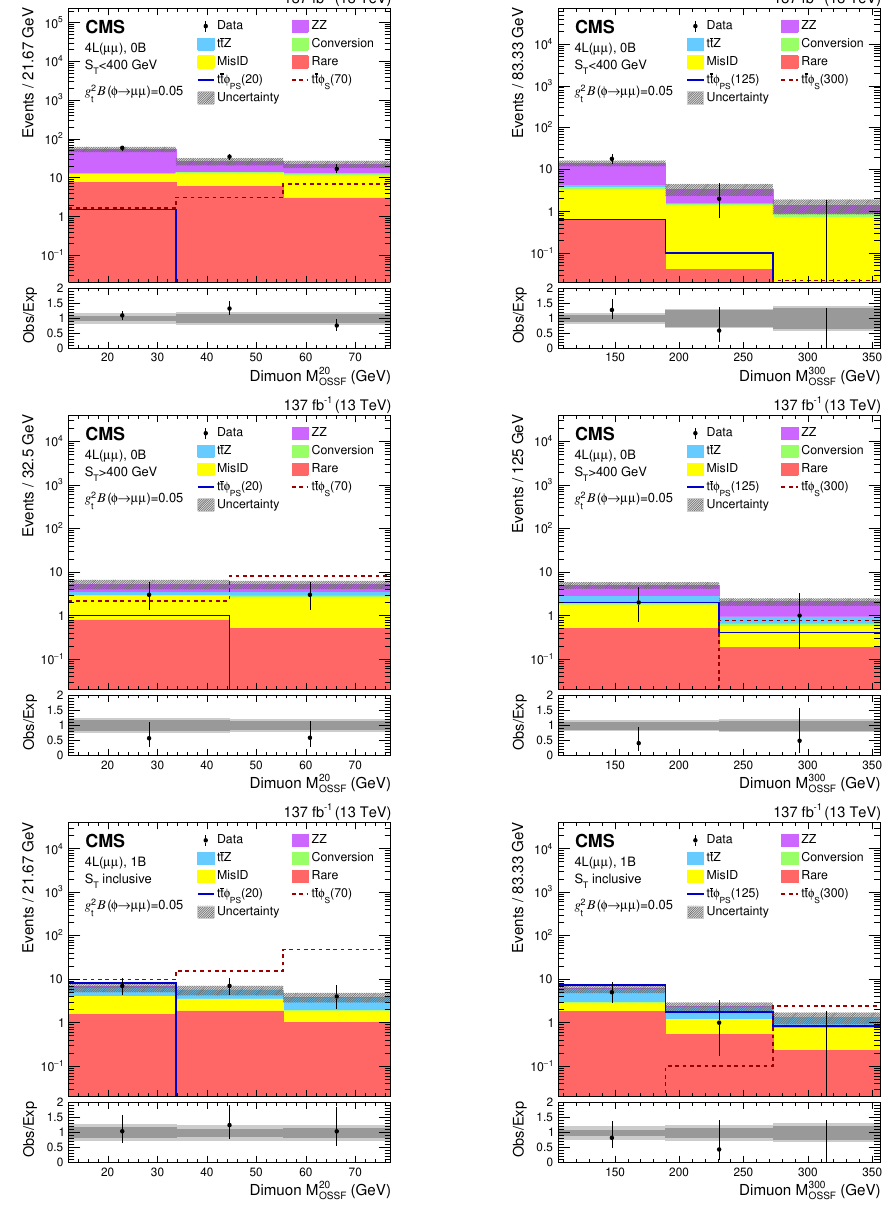
Figure 10 . Dimuon M 20 (left column) and M 300 (right column) distributions in the 4L( (cid:22)(cid:22) ) OSSF OSSF tt (cid:30) signal regions. Upper, center, and lower plots are for 0B S < 400 GeV, 0B S > 400 GeV, T T and 1B S -inclusive, respectively. The total SM background is shown as a stacked histogram of all T contributing processes. The predictions for tt (cid:30) ( ! (cid:22)(cid:22) ) models with a pseudoscalar (scalar) (cid:30) of 20 B ( (cid:30) ! (cid:22)(cid:22) ) = 0 : 05 are also shown. The lower panels and 125 (70 and 300) GeV mass assuming g 2 t show the ratio of observed to expected events. The hatched gray bands in the upper panels and the light gray bands in the lower panels represent the total (systematic and statistical) uncertainty of the backgrounds in each bin, whereas the dark gray bands in the lower panels represent only the statistical uncertainty of the backgrounds. The rightmost bins do not contain the over(cid:13)ow events as these are outside the probed mass